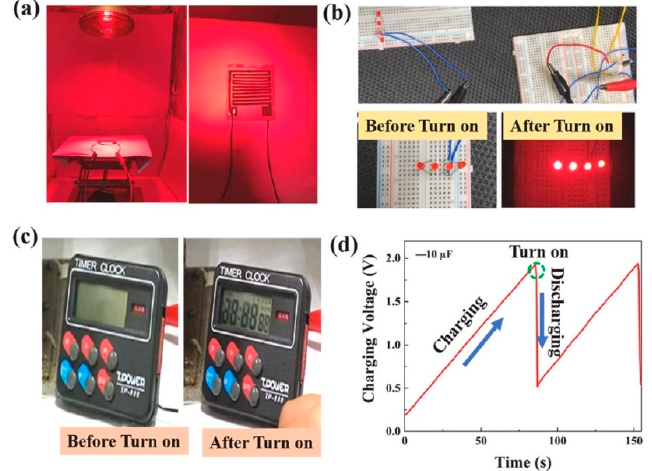
Figure 18. Application of the PVDF/Cs 0.33 WO 3 PyNG designed by Gokana et al. [91]. ( a ) Experi ‐ mental setup of the PyNG to turn on ( b ) four lighted LEDs and ( c ) display LCD. ( d ) Charging and discharging voltage of 10 μ F capacitor using the PVDF/Cs 0.33 WO 3 PyNG. Reprinted with permission from [91]. Copyright 2022, Elsevier B.V. Table 1 reported the comparison of the main characteristics of various nanogenerator types, including the transduction mechanism, energy source, materials, advantages, and weaknesses. For a single transduction mechanism, the triboelectric nanogenerators have important characteristics such as high electrical output performance, good stability, sim ‐ ple structure, and cost ‐ efficient fabrication. In addition, this nanogenerator can be de ‐ signed to convert different energy sources (e.g., biomechanical, water waves, environmen ‐ tal vibrations, and wind) into electrical energy. On the other hand, the hybrid nanogener ‐ ators present an enhanced electrical output performance in comparison with nanogener ‐ ators based on a single transduction mechanism. The hybrid nanogenerators that include the triboelectric effect have the best operation parameters such as compact and simple structure, good flexibility, stability, low ‐ cost manufacturing, and high electrical output performance. Table 1. Summary of the main characteristics of several nanogenerators used to harvest different green energy sources. Transduc ‐ tion Mecha ‐ nism